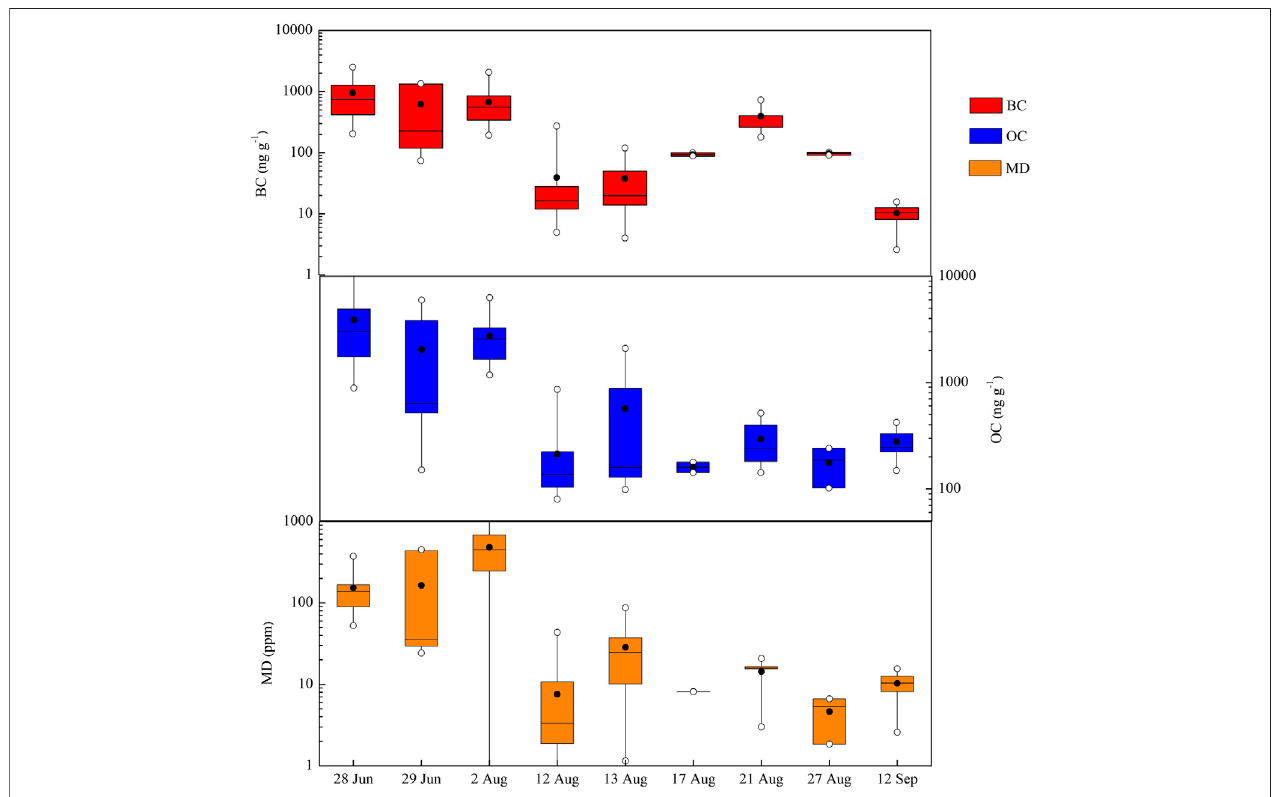
FIGURE 4 | Temporal variations of LAIs ’ concentrations during the snowmelt period,